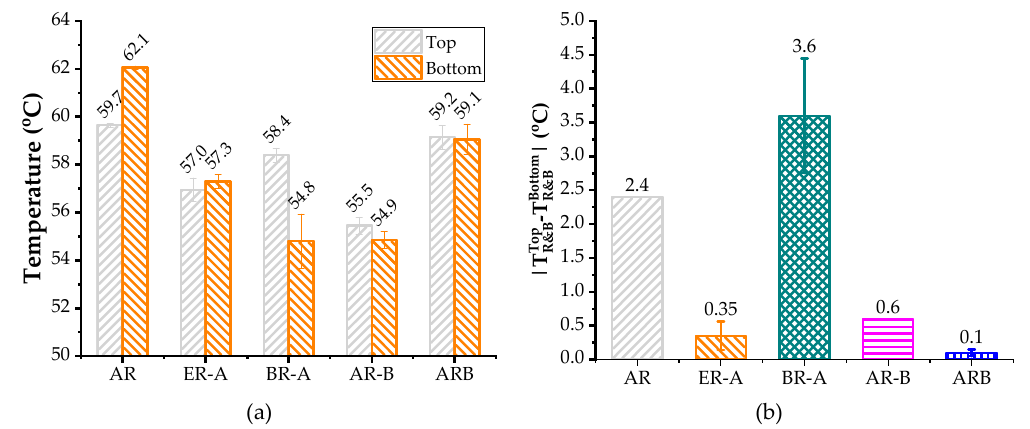
Figure 7. Softening point difference of test binders after storage: ( a ) Softening points of top and bottom sections. ( b ) D-value between top and bottom sections.